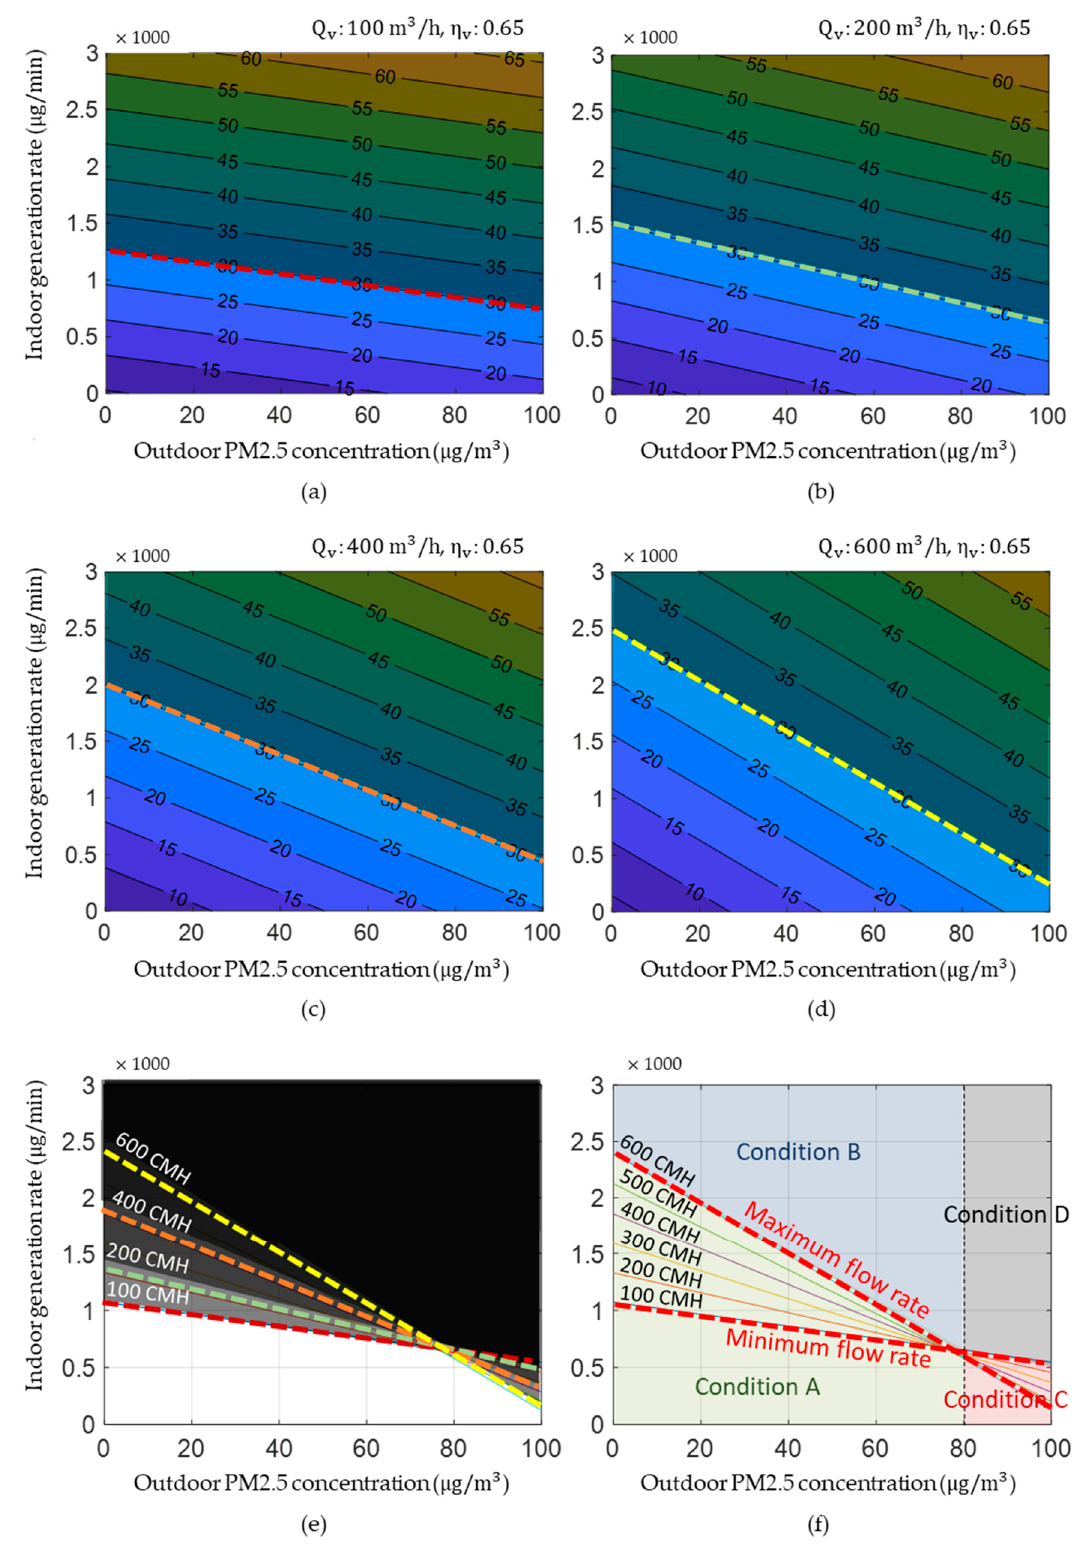
Figure 6. ( a – d ) Indoor particle concentration characteristics depending on the ventilation rates when the filter efficiency of system is 0.65; ( e ) ventilation control limit graphs to maintain the target indoor PM that vary with ventilation flow rates; and ( f ) indoor and outdoor particle conditions separated by the ventilation control limit.